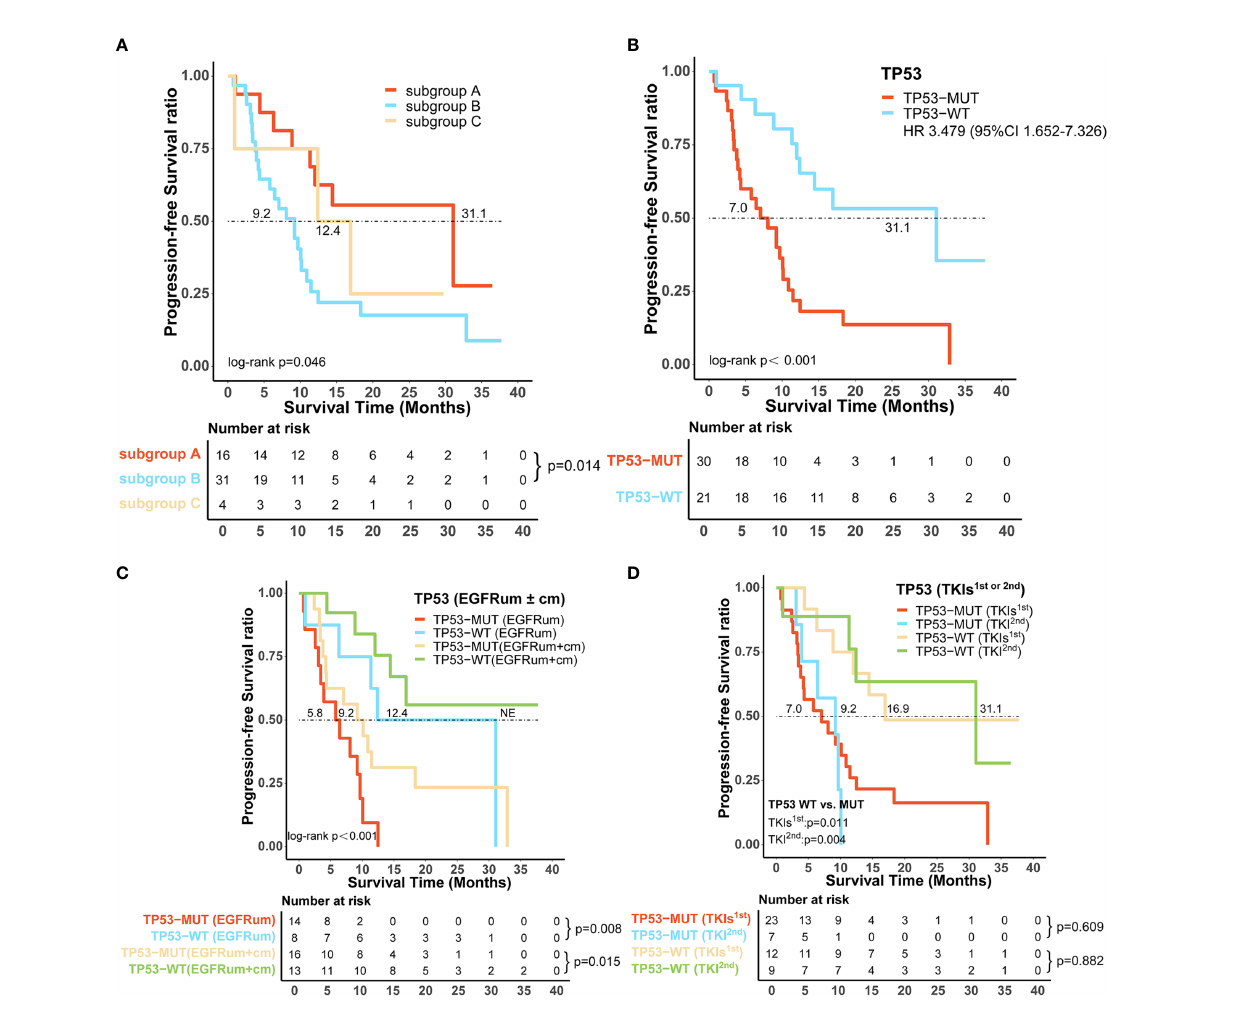
FIGURE 6 | Certain co-alterations were associated with inferior survival outcomes in patients with uncommon EGFR mutations treated with EGFR -TKIs. (A) Progression-free survival (PFS) among patients without co-mutation (subgroup A), with co-mutations of tumor-suppressor genes (subgroup B) and driver oncogenes (subgroup C). (B) TP53 -mutated ( TP53 -MUT) patients showed signi fi cantly shorter median PFS than TP53 wild-type ( TP53 -WT) patients. The predictive value of TP53 co-mutations in the survival outcomes of patients harboring uncommon EGFR mutations (C) with or without a combined common EGFR mutation, (D) receiving different generations of EGFR -TKIs. EGFR cm, common EGFR mutations; EGFR um, uncommon EGFR mutations; HR, hazard ratio; 95% CI, 95% con fi dence